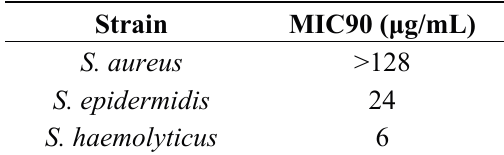
Table 1. Bacterial strains’ minimal inhibitory concentration